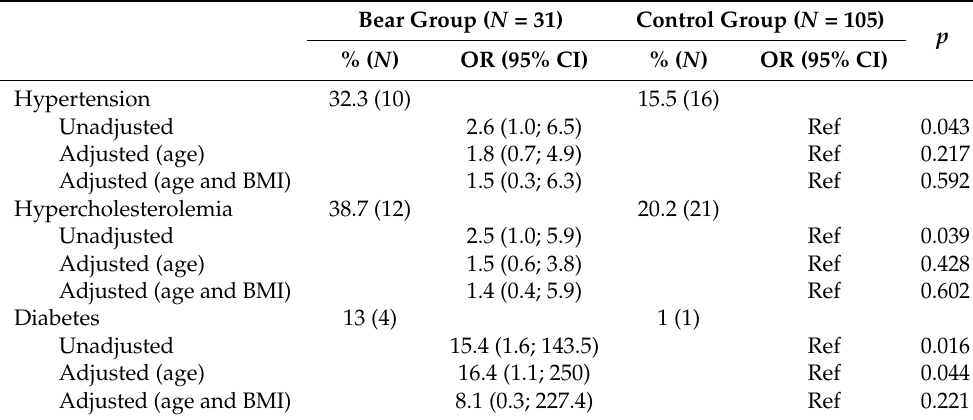
Table 3. Comparison of Bears with other gay men in terms of the prevalence of medical risk factors for cardiovascular